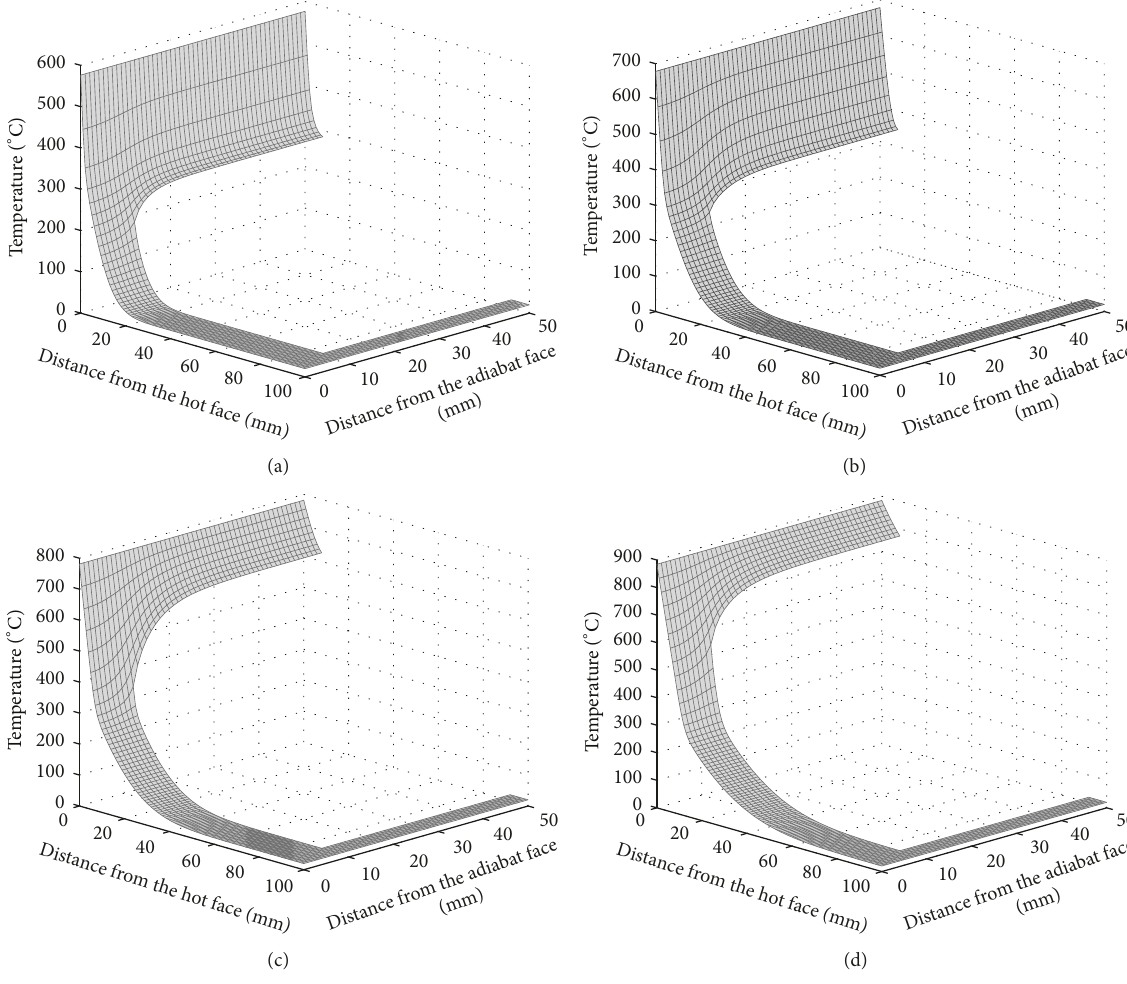
Figure 4: Temperature distribution of GFRP tube: (a) 5min, (b) 10min, (c) 20min, and (d)